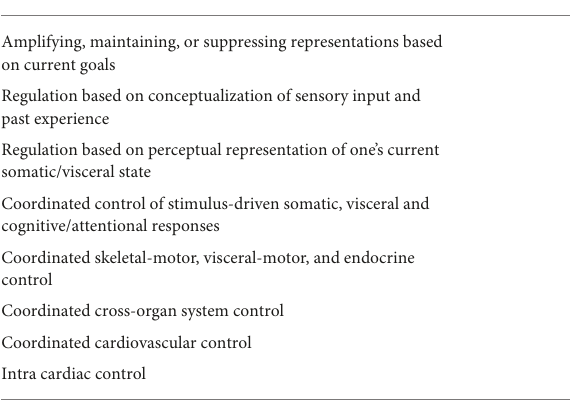
TABLE 4 Extended NVI models eight levels and hierarchical structure of vagal control – from high to low level (Smith et al., 2017).